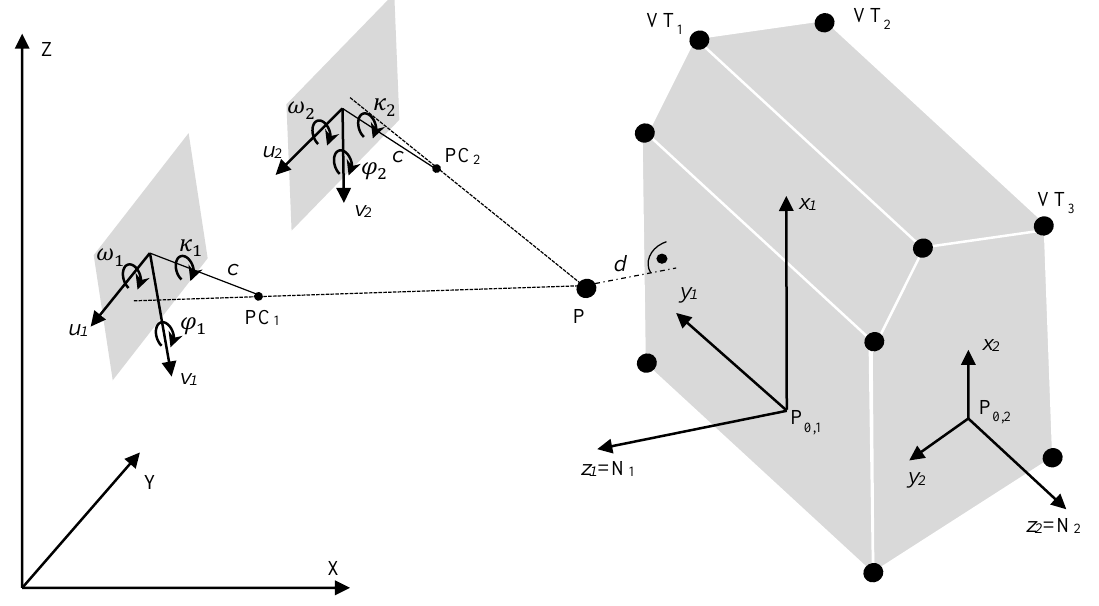
Figure 1: Relevant entities in our scenario. Two cameras i with identical camera constant c , image coordinate axes ( u i , v i ), projection centres PC i and three rotation angles (  i ,  i ,  i ) with i  {1,2} represent the multi-view scenario where sensors capture an object point P in world coordinates X, Y, Z. The generalised building model is represented by corner points VT k with i  {1,2, … } in world coordinates and by the planes they are situated in. Each plane j has a local coordinate system ( x j , y j , z j ) where the local z j - axis is the plane normal N j and x j , y j are axes in the plane. The origin of the coordinate system of plane j is 𝑃 0,𝑗 , and each plane coordinate system is rotated relative to the world coordinate system by three angles (  j ,  j ,  j ) that are not shown in the figure. The orthogonal distance of an object point P to a corresponding plane of the building model is denoted by d